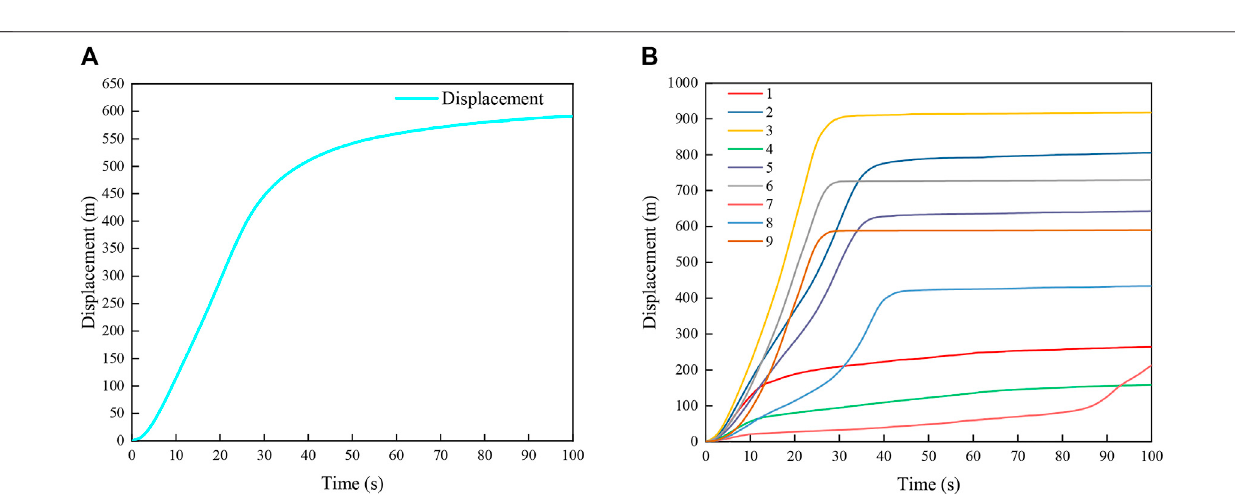
FIGURE 10 | (A) Average displacement of the slide body and (B) displacements of the monitoring points in the slide